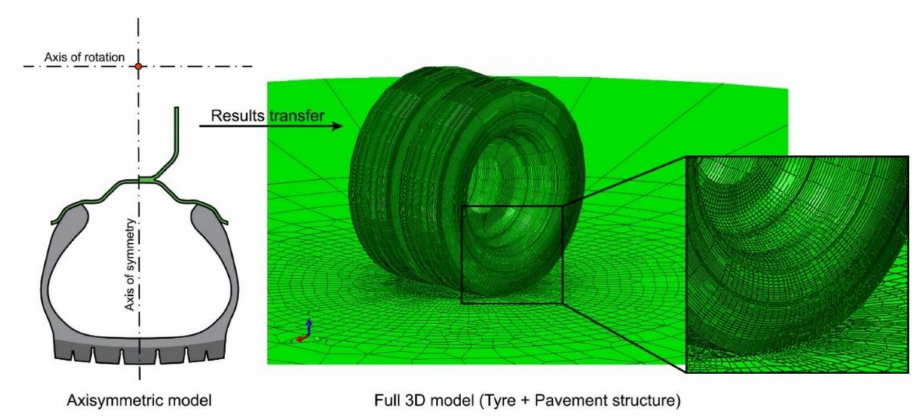
Figure 4. Symmetric results for static 3D tyre analysis of the tyre–pavement